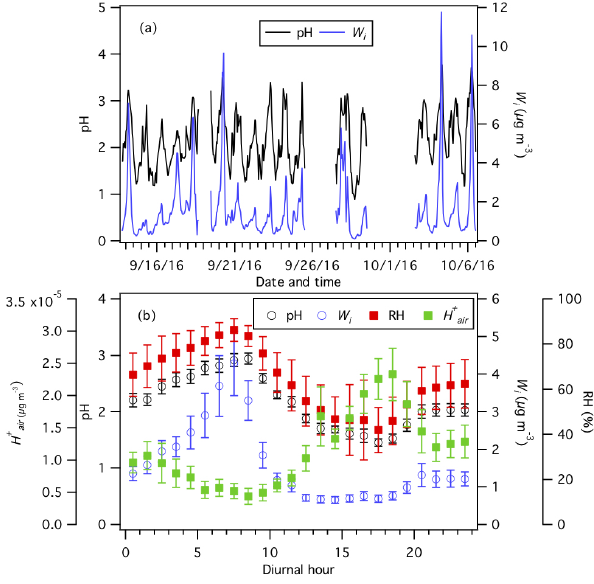
Figure 3. (a) Time series and (b) diurnal profiles of ISORROPIA- predicted PM 1 pH and W i . The diurnal profiles of RH and ISORROPIA-predicted H + are also shown in (b) . Dates and times air displayed are local time. All the data shown here represent averages in 1h intervals. Error bars shown in (b) are the standard